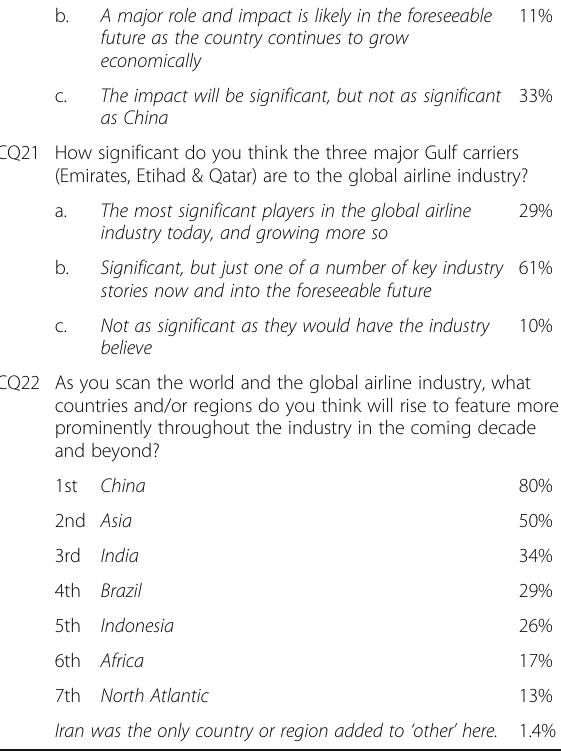
Table 1 Main survey 1: multiple choice questions (MCQs).